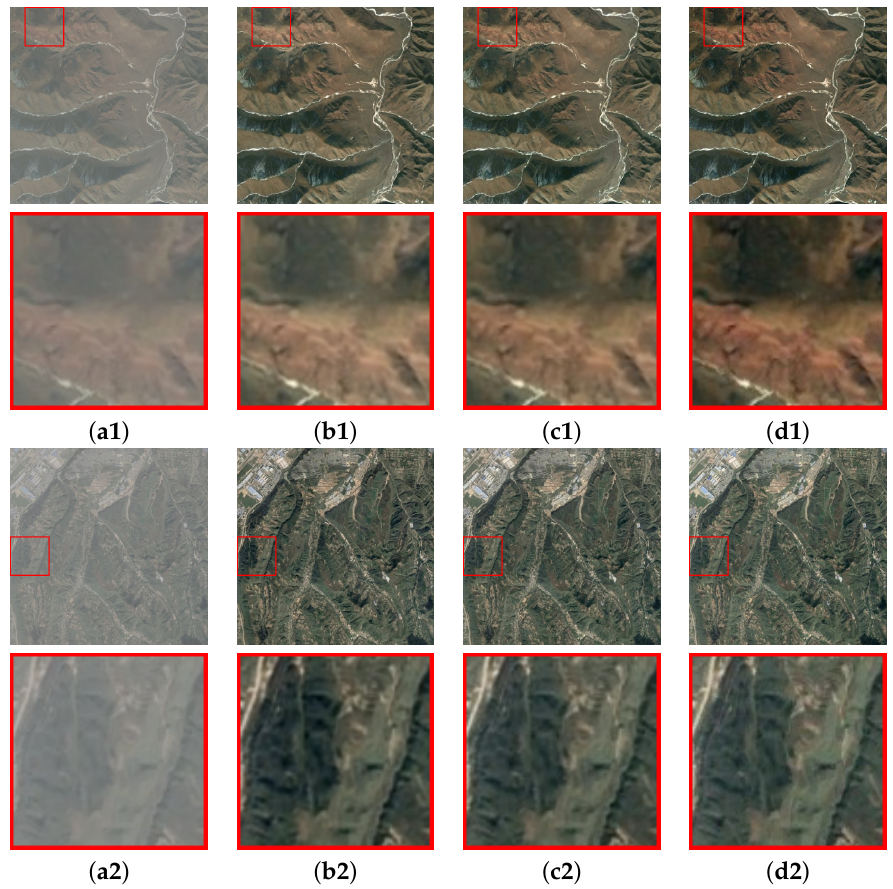
Figure 7. Comparison of the effects of CNN and transformer structures on two RICE1 samples. ( a1 , a2 ) represent the input cloudy images. ( b1 , b2 ) represent the results of the CNN which corresponds to Method 1 in Table 1. ( c1 , c2 ) represent the results of the transformer which corresponds to Method 2 in Table 1. ( d1 , d2 ) represent the groudtruth images. The transformer structure shows better results than CNN in restoring the brightness and color of